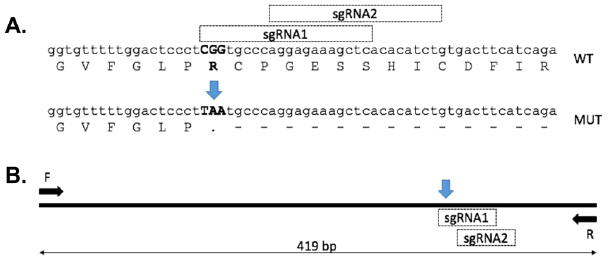
Figure 1. CRISPR/Cas9 engineering of PPT1 sheep ( A) sgRNAs were designed proximal to the PPT1 target site on Ovis aries chromosome 1 (indicated by blue arrow). ( B) Sheep zygotes were injected with Cas9 mRNA,